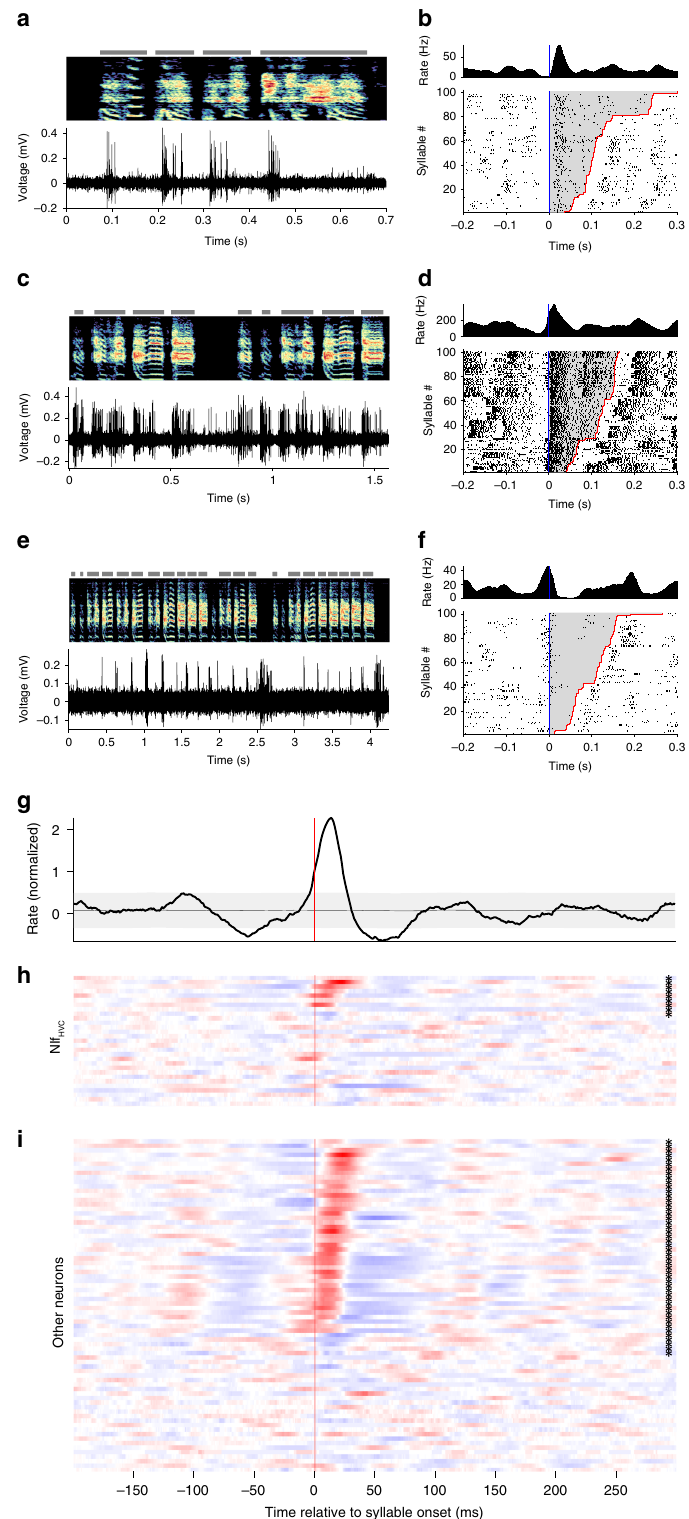
ensembles during the tutoring phase and reproduced those syllables during the singing phase on 98/100 random initializa- tions. The network was also largely successful when trained on three (81/100 successful runs) or fi ve (79/100) syllables. Previous models of HVC sequence formation incorporated syllable-speci fi c training neurons as an input to HVC 40,42